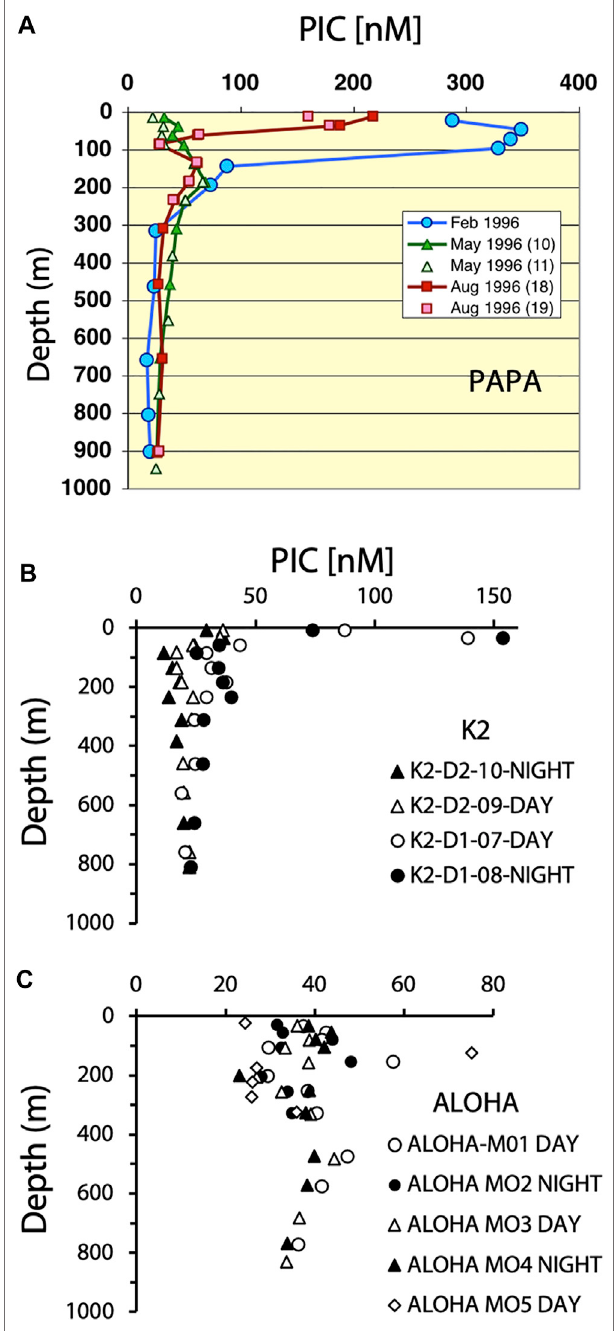
FIGURE 1 | Pro fi les of particulate inorganic carbon (PIC) at locations in the subarctic North Paci fi c, Oyashio current near Japan, and from station ALOHA.DataarethesumofPICdeterminedin1 – 51and > 51 µmparticle size fractions collected during casts of the multiple unit large volume in situ fi ltration system. (A) Seasonal data from ocean station PAPA (50 ° N 145 ° W) during February, May, and August, 1996. (B , C) Data from the VERTIGO project during 21-day occupations of station K2 (47 ° N, 161 ° E) and station ALOHA (22.75 ° N, 158 ° W).